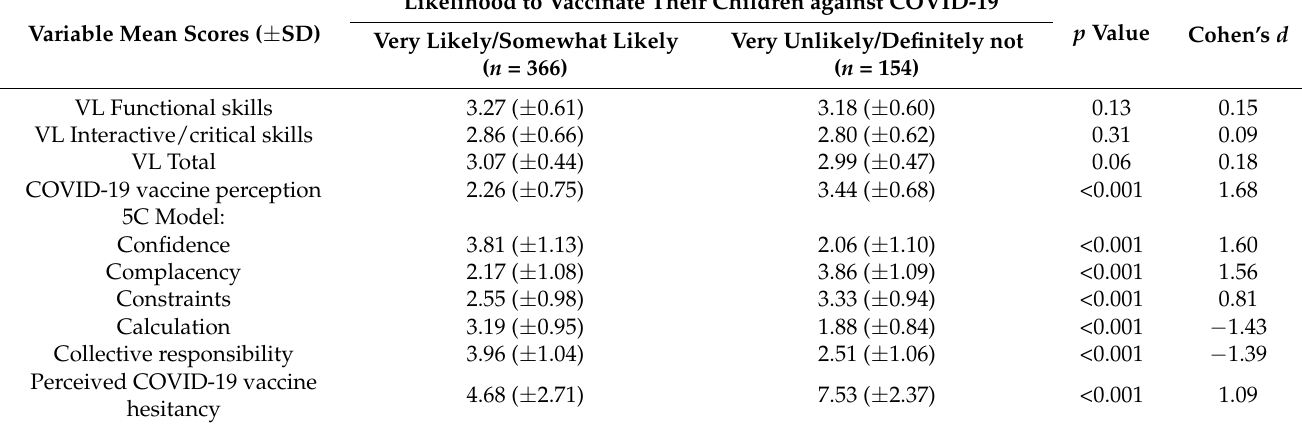
Variable Mean Scores (±SD)